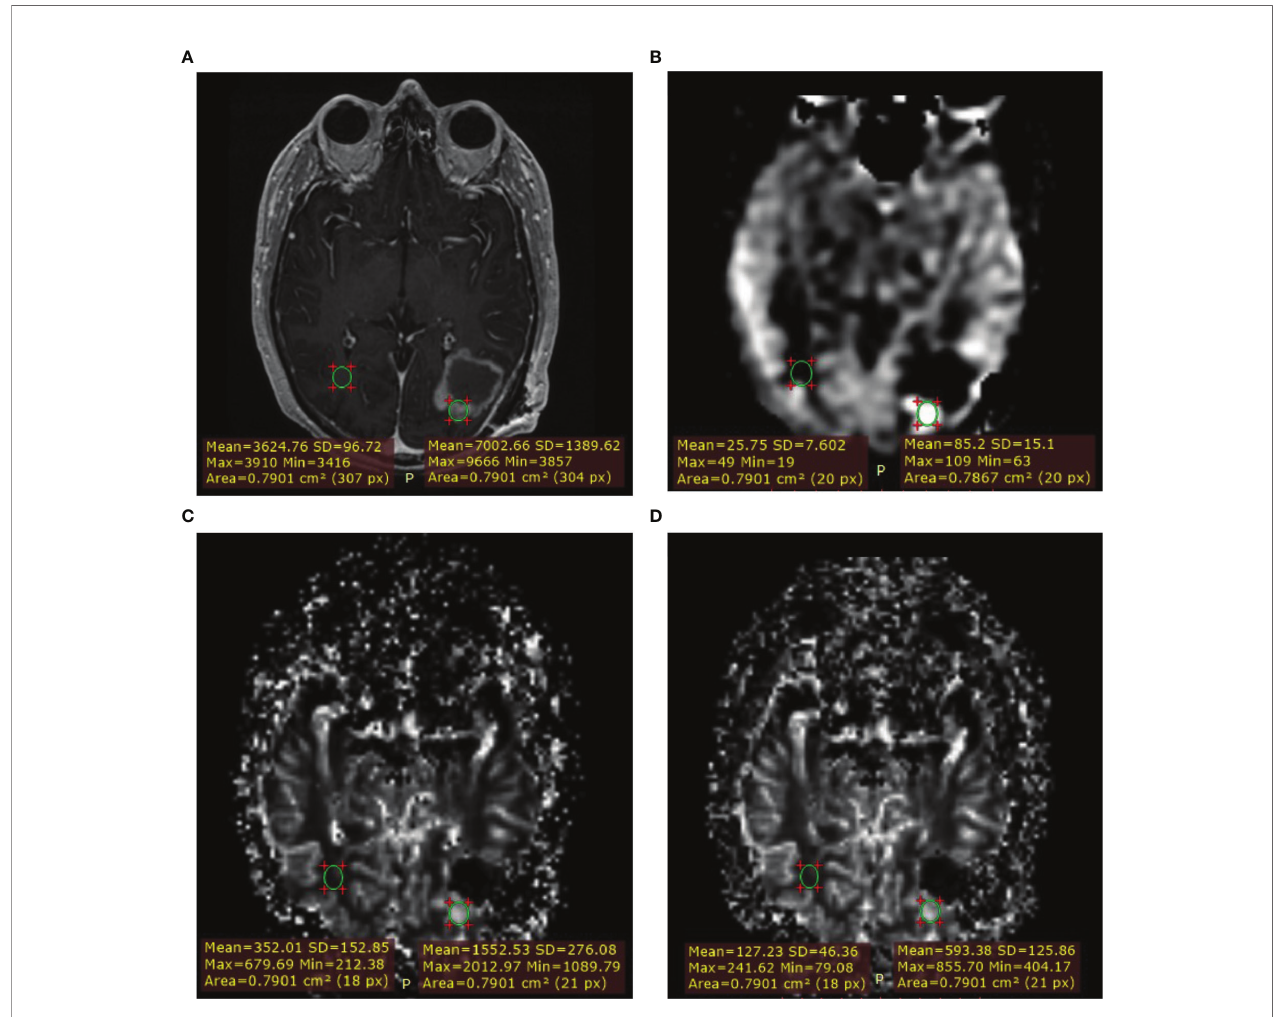
FIGURE 1 | Example of measurement with region of interest (ROI) placement. Lesion ROI and contralateral normal appearing white matter (NAWM) ROI. (A) T1W+Gd. (B) ASL-CBF. (C) DSC-rCBV. (D) DSC-rCBV leakage